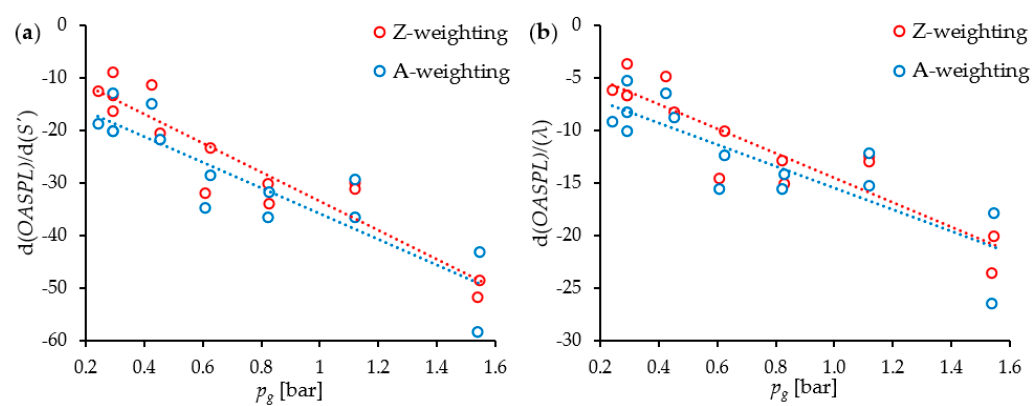
Figure 9. The derivative of the fitted linear trend lines as a function of the atomizing pressure. ( a ) geometric swirl number, ( b ) air-to-fuel equivalence ratio.